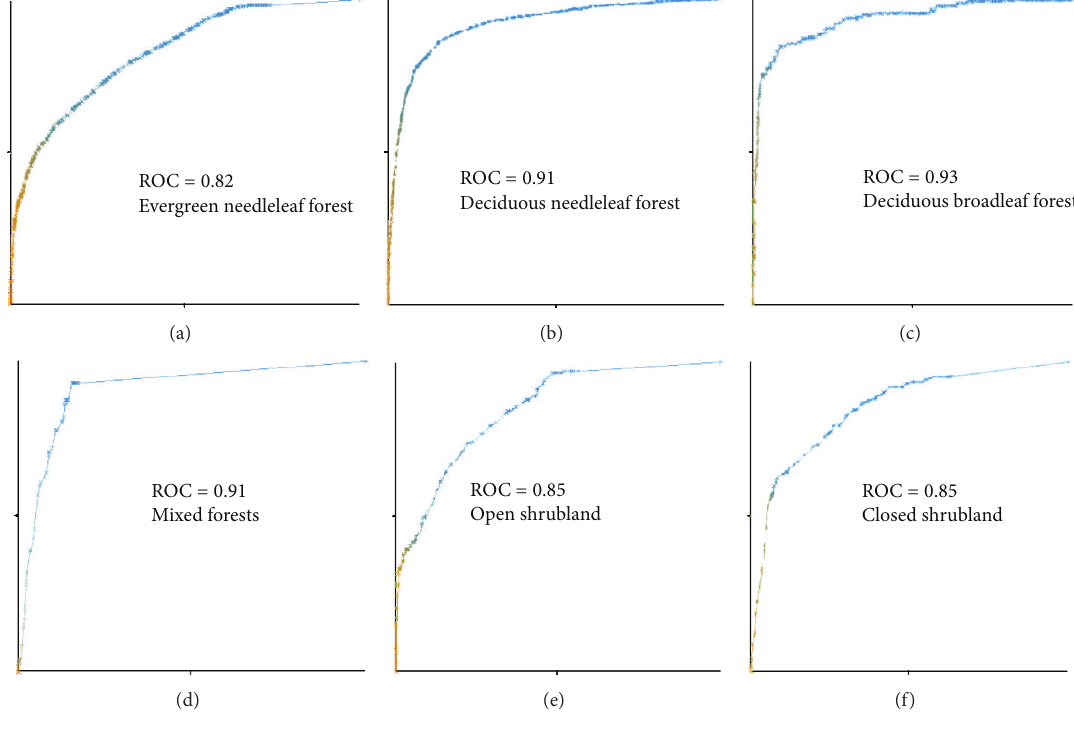
Figure 6: The ROC curve value of different vegetation class rule.